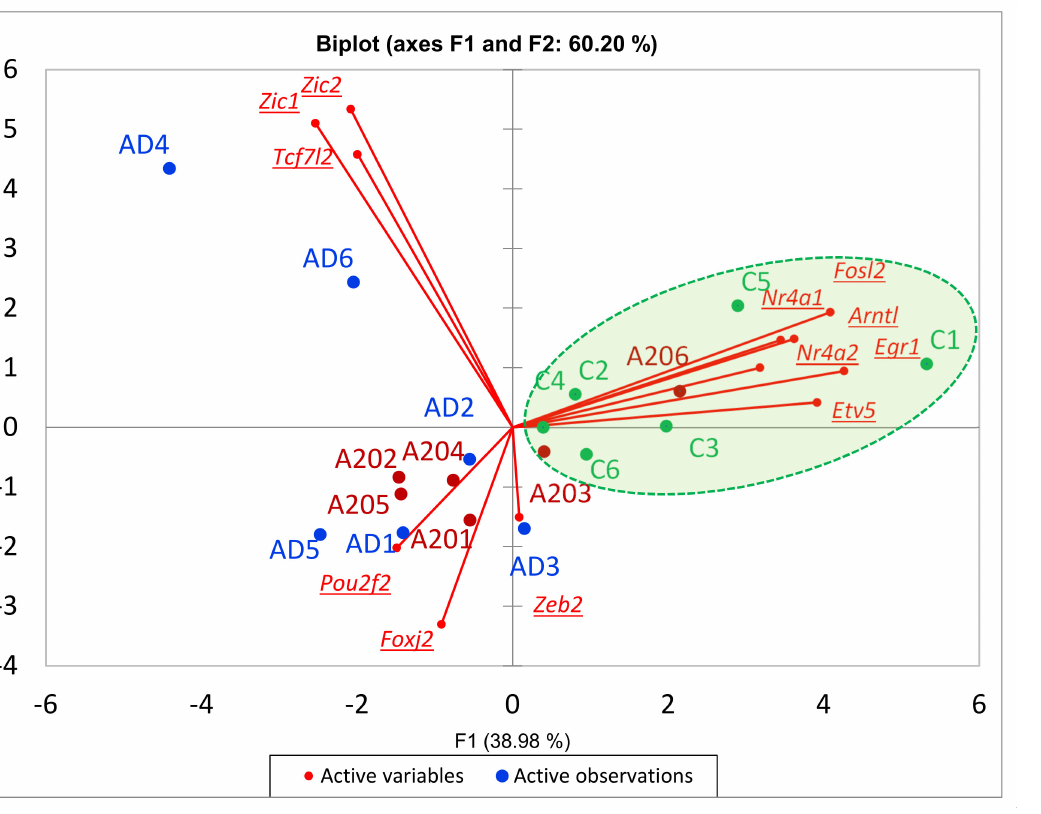
Figure 2. PCA biplot outlines distinct alteration of TF programs (3 DEG clusters) between AD (blue), A20 (red) and control (green) groups. Green shaded area is control